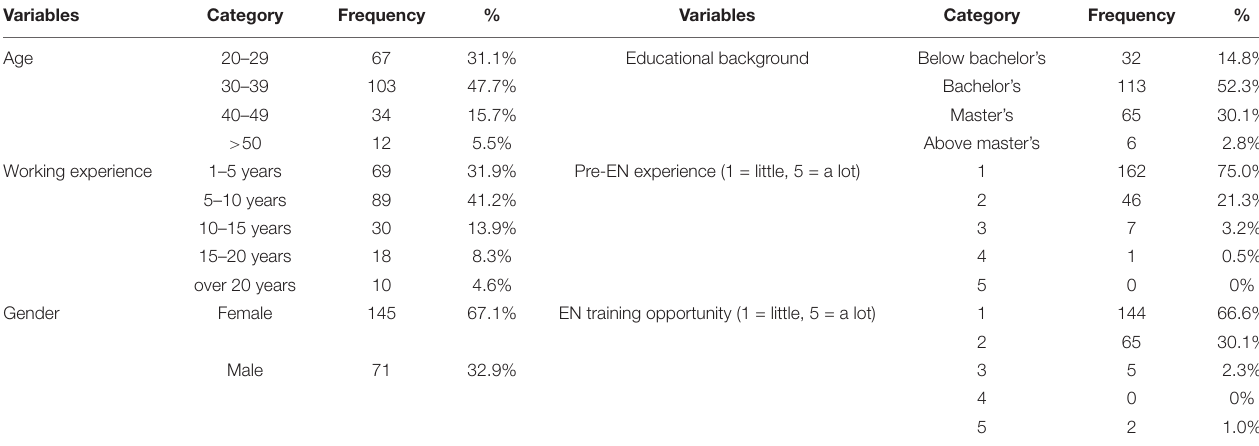
TABLE 2 | Descriptive statistics and reliability of each subscale.